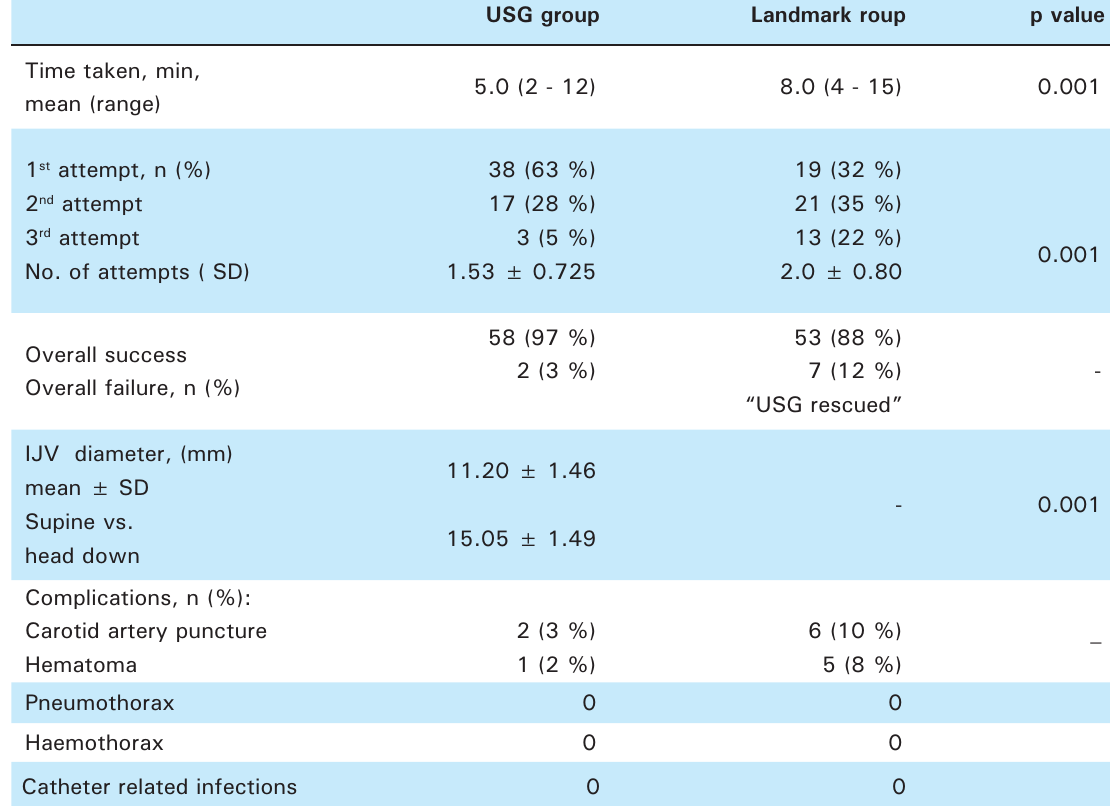
Table 2. Outcome measures. The values are mean or number (SD) or (%). USG group Landmark roup p